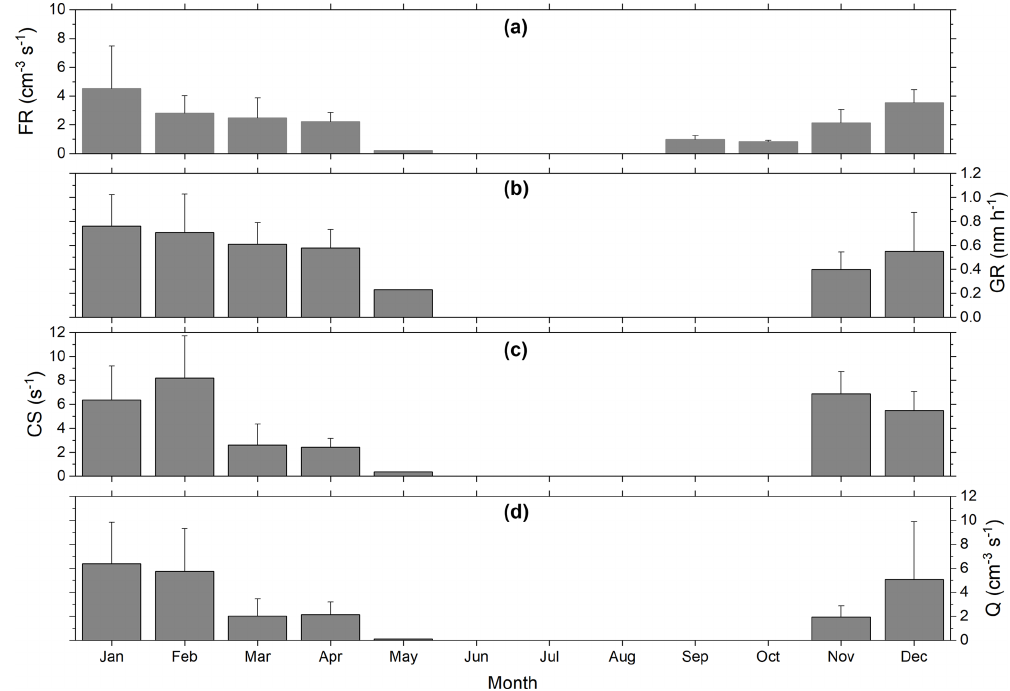
Figure 4. Monthly variations of (a) the formation rates (FR), (b) the growth rates (GR) of nucleation mode particles ranging from 10 to 25nm, (c) the condensation sink (CS) and (d) the source rate of condensable vapor ( Q ). The error bars represent a standard deviation. No NPF events were observed in June, July and August. The GRs, CSs and Q values in September and October were not shown due to mechanical troubles of the instruments.